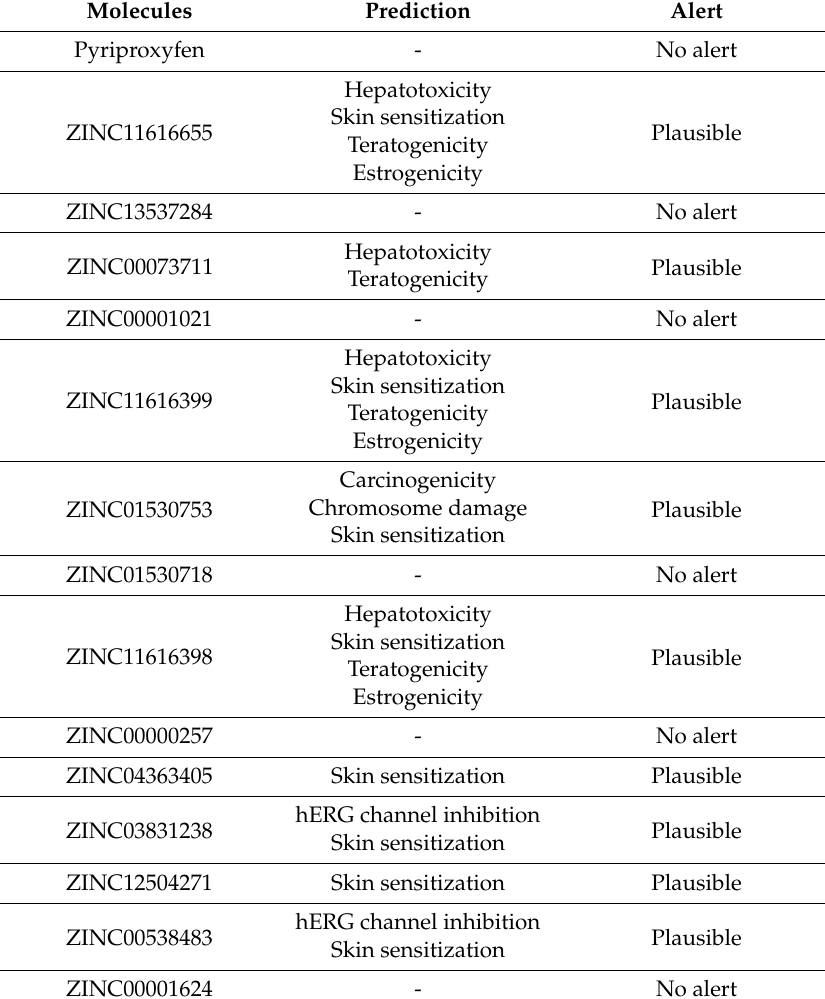
Table 2. Predictions of the toxicological properties of